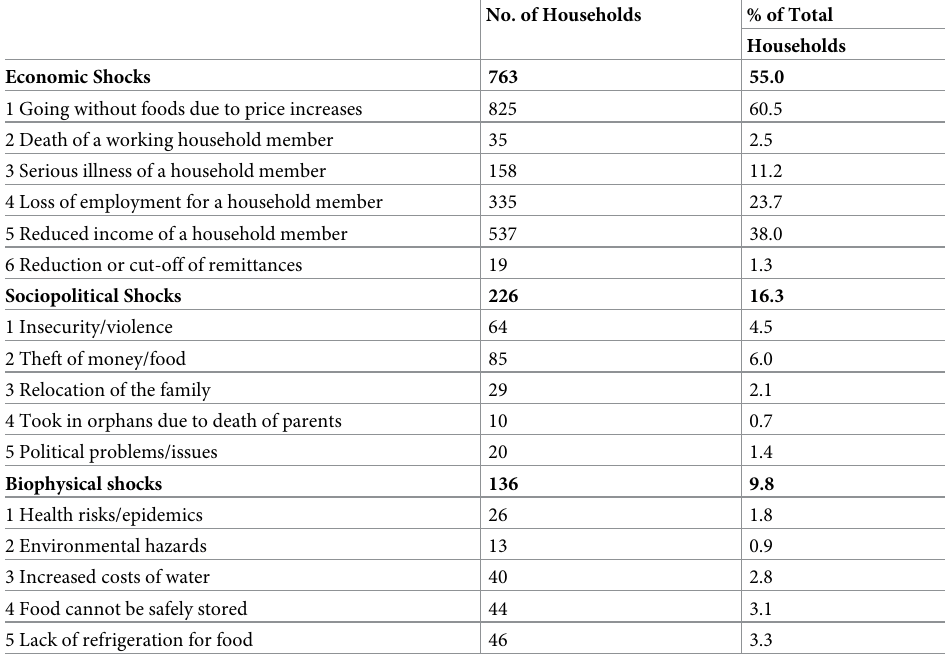
Table 4. Experience of household